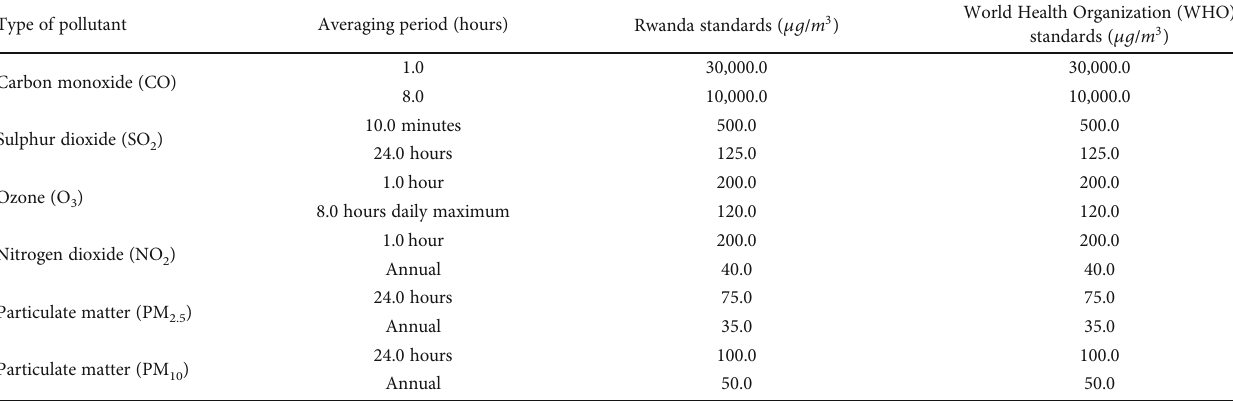
Table 2: Rwanda air quality standards versus WHO air quality guidelines [17 – 19].